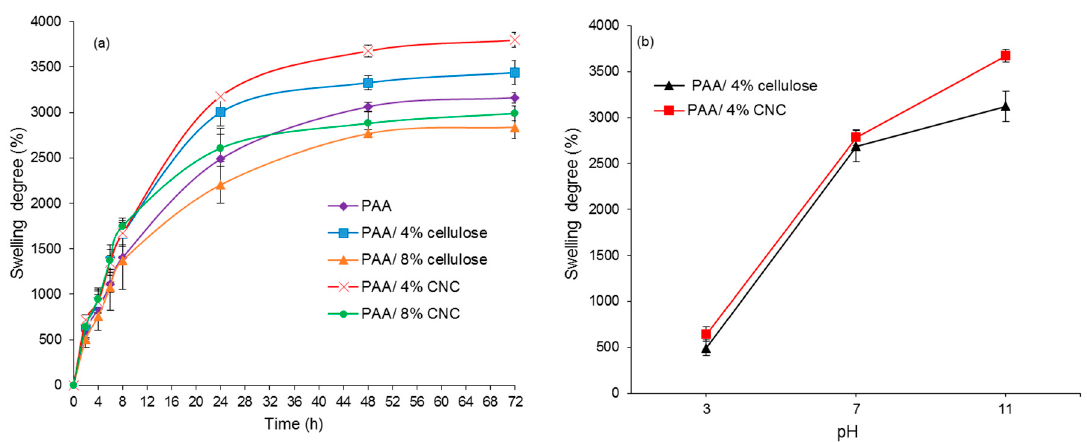
Figure 8. ( a ) Effect of filler composition on the swelling percentage of PAA hydrogels at pH 11 and ( b ) effect of pH on swelling percentage of PAA hydrogels.